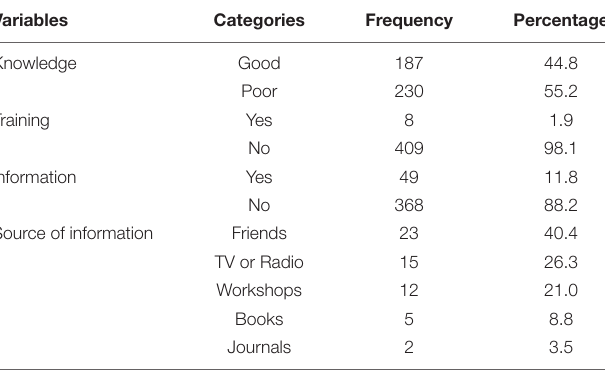
TABLE 2 | Attention deficit hyperactivity disorder-related knowledge of primary school teachers of Debre Markos and Dejen towns, 2018.